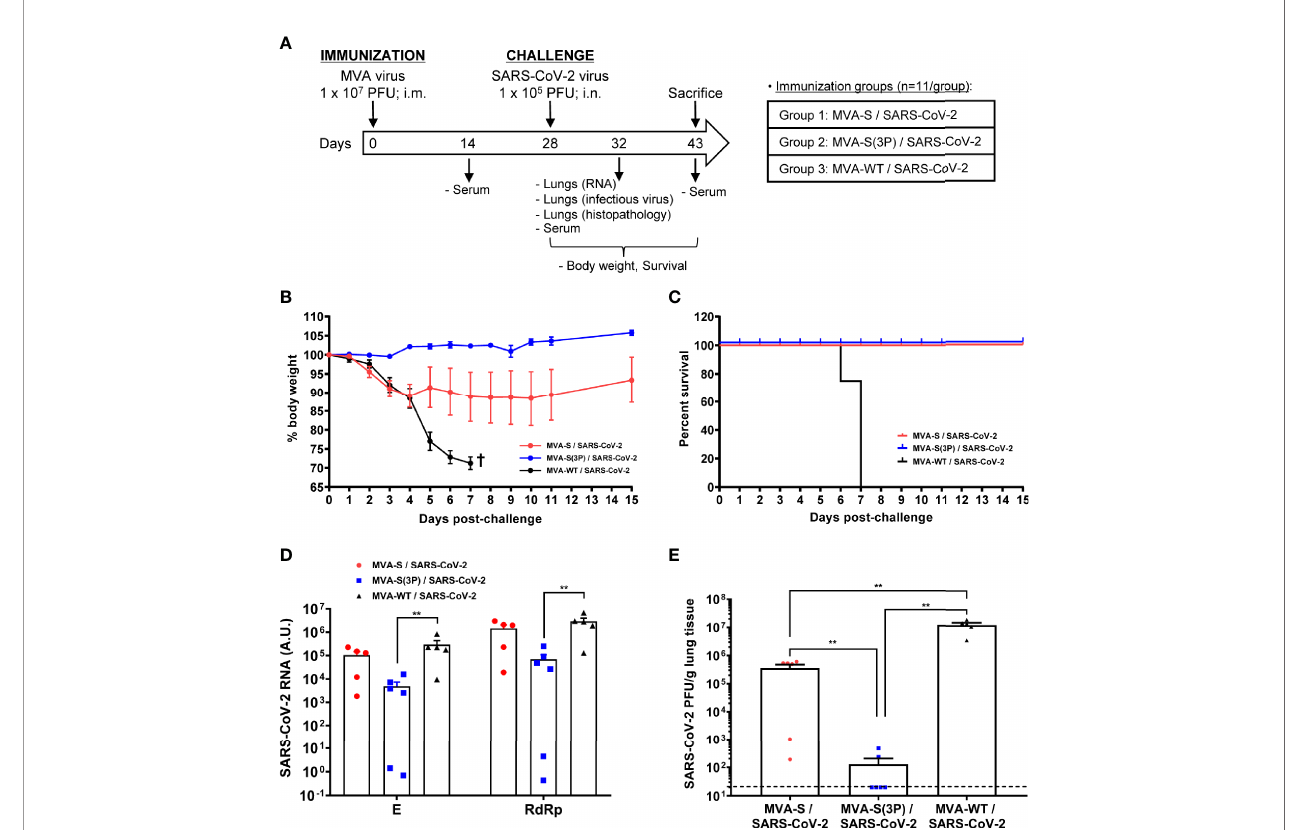
FIGURE 4 | One dose of MVA-S(3P) protects transgenic K18-hACE2 mice from SARS-CoV-2 infection. (A) Ef fi cacy schedule. Male and female K18-hACE2 transgenic mice ( n = 11 per group) were immunized by the intramuscular (i.m.) route with one dose of 1 × 10 7 PFU of MVA-S(3P) or MVA-S as indicated. At week 4 (day 28), mice were challenged intranasally (i.n.) with 1 × 10 5 PFU of SARS-CoV-2 (MAD6 isolate). MVA-WT-inoculated mice were also i.n. challenged with SARS- CoV-2 and used as a control. At day 4 postchallenge, 6 mice per group were sacri fi ced and lungs and serum samples were collected as indicated. Serum was also collected at 14 days after immunization and in mice alive at 15 days postchallenge (groups 1 and 2). (B, C) The challenged mice were monitored for change of body weights (B) and mortality (C) for 15 days. † : mice were euthanized due to loss of more than 25% of initial body weight. (D) Virus replication in lung samples. Subgenomic (E) and genomic (RdRp) SARS-CoV-2 RNA detected by RT-qPCR at 4 days after virus infection ( n =6). Mean RNA levels (in arbitrary units [A.U.]) and SEM from duplicates of each lung sample; relative values are referred to uninfected mice. (E) SARS-CoV-2 infectious virus in lung samples. Mean (PFU/g of lung tissue) and SEM from triplicates of each lung sample. Student ’ s t -test: ** p <